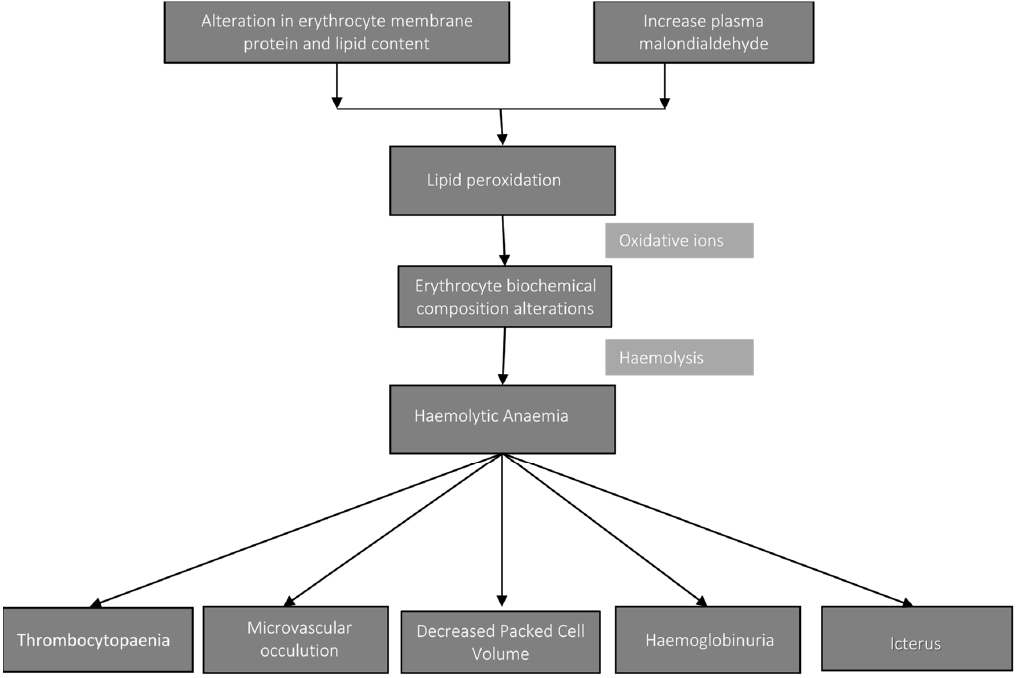
Figure 5. Schematic presentation of pathophysiology of anemia in equine piroplasmosis. The flowchart illustrates the sequence of events that culminates in anemia and other pathological sequellae.